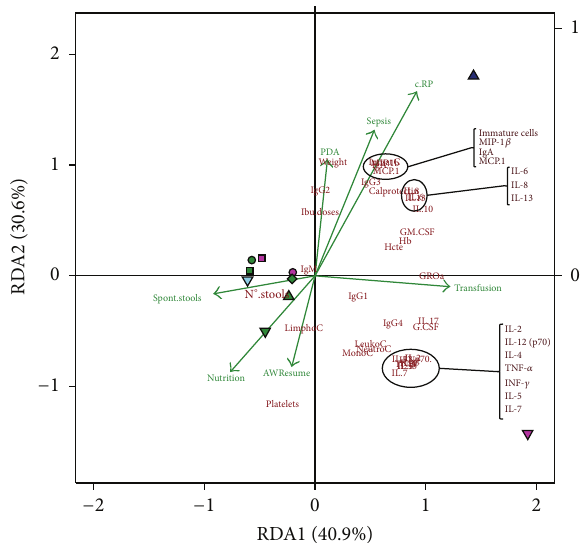
Figure 3: Redundancy analysis of the blood samples obtained at different sampling times from the preterm infants. Cases were represented with points and then labeled per infant (1: circle, 2: square, 3: diamond, 4: triangle, and 5: inverted triangle) and sampling time (0: medium violet red, 7: green, 14: midnight blue, and 21: sky blue) Quantitative variables matrix, including the hematological and immunological parameters, ibuprofen doses (Ibu.doses), number of stools per day (N ∘ .stools), and weight, was represented with each variable name or abbreviator in dark red color; clinical categorized observations vectors matrixes were used as constrained variables (airway resume (AWResume), antibiotherapy (Antibiotics), C-RP, ibuprofen treatment (Ibu treatment), nutrition type (Nutrition), patent ductus arteriosus (PDA), Sepsis, spontaneous stools (Spont.stools), and Transfusion) and represented as vectors in green color. The bidimensional RDA plot explains the 71% of the variability and showed a 𝑃 value of 0.010 after 199 permutations when ANOVA test of the model was